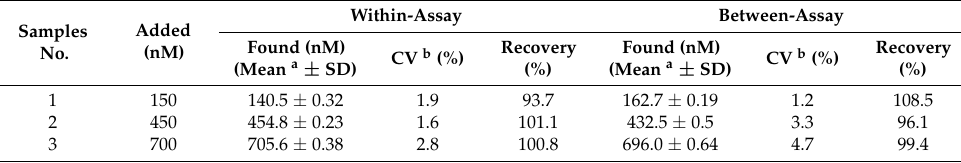
Table 1. Determination of Hg 2+ in tap water samples using the proposed radial flow assay. Samples No.